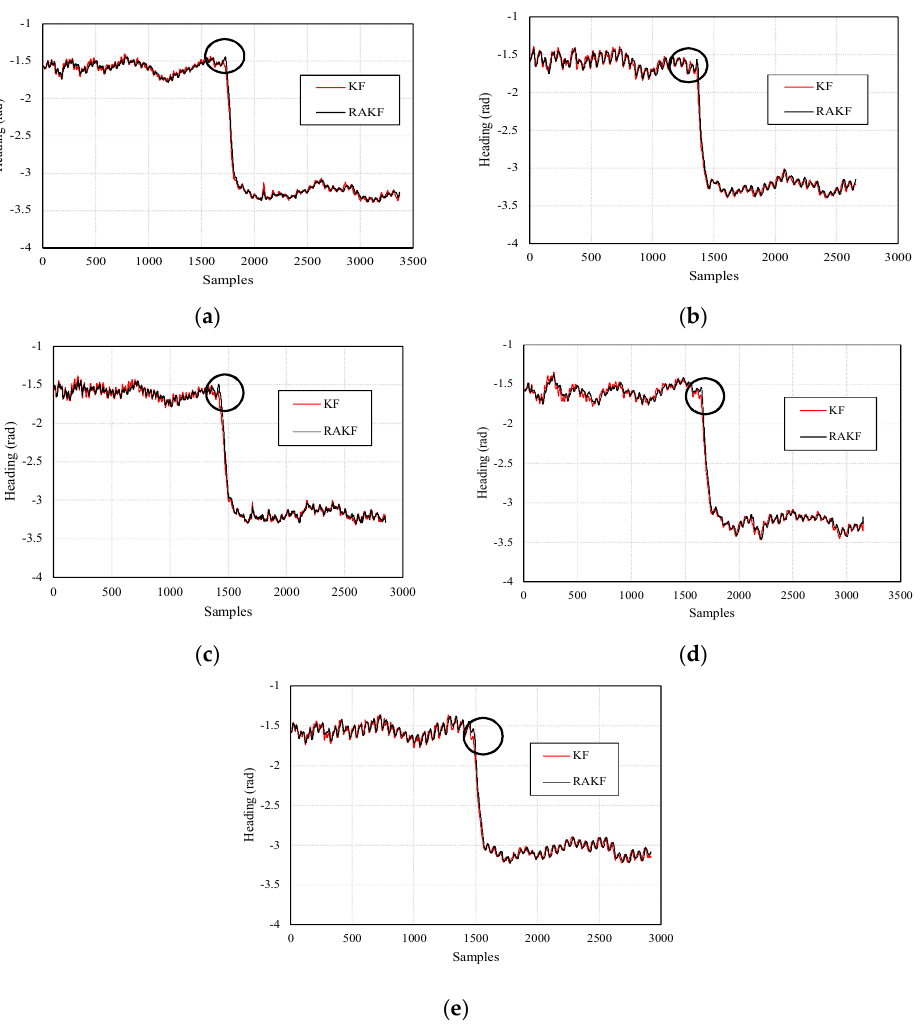
Figure 10. Comparisons of the performances on heading estimation of KF and RAKF regarding five participants, ( a ) participant 1, ( b ) participant 2, ( c ) participant 3, ( d ) participant 4, and ( e ) participant 5.